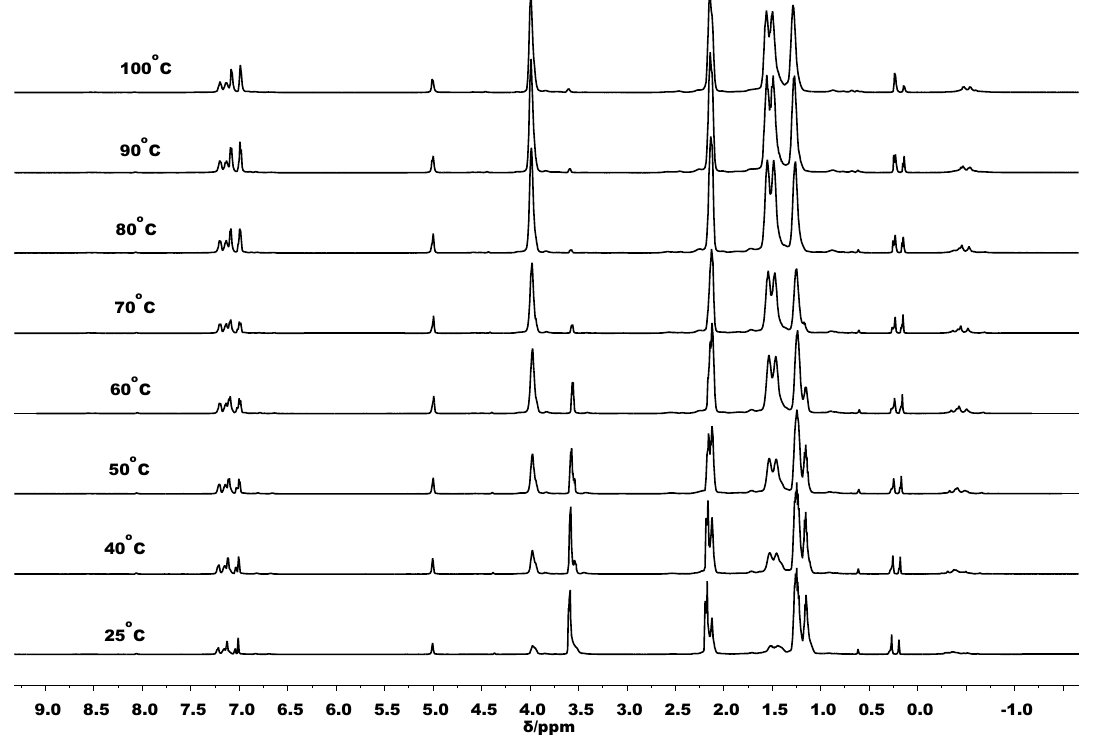
Figure 11. VT- 1 H NMR spectra of C1/ BnOH/10 ε -CL recorded at temperatures between 25 and 100 °C (in toluene- d 8 ).